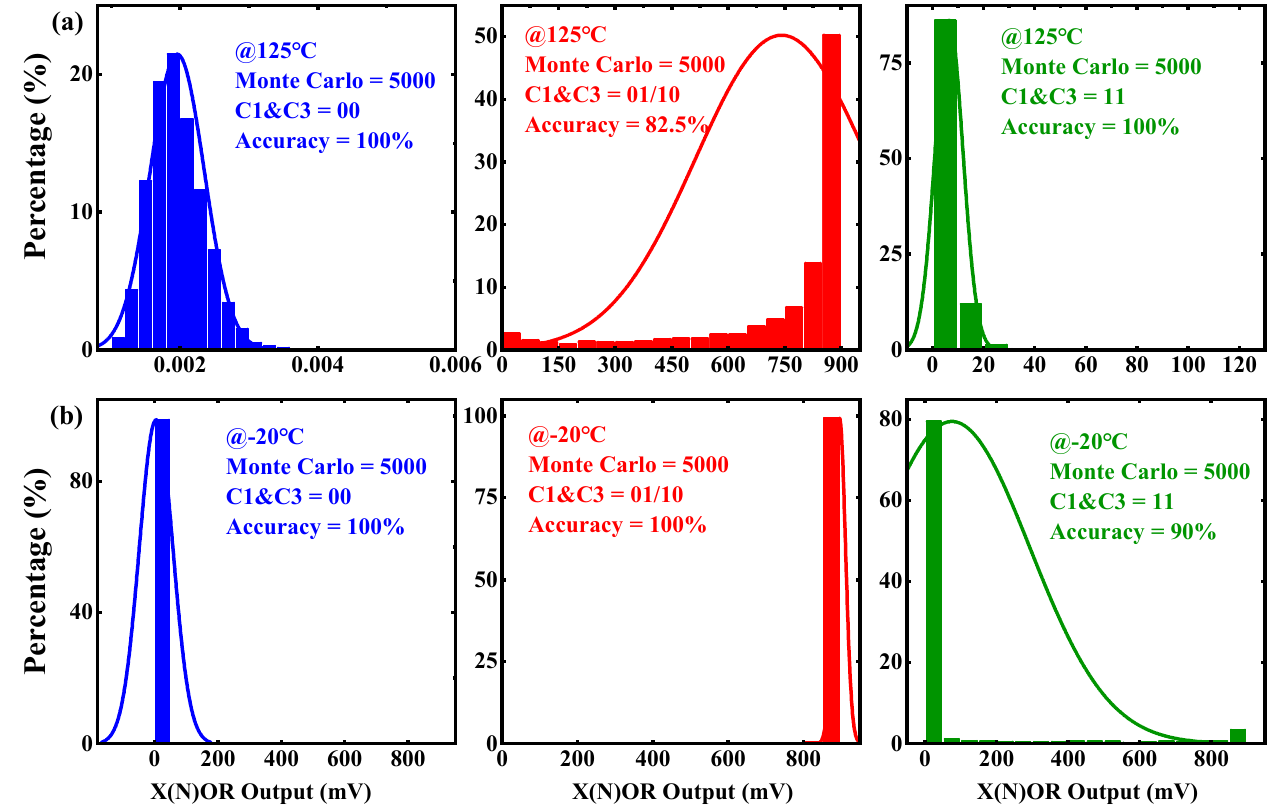
Figure 20. Monte Carlo simulation results of X(N)OR ( a ) at 125 °C ( b ) at − 20 °C.